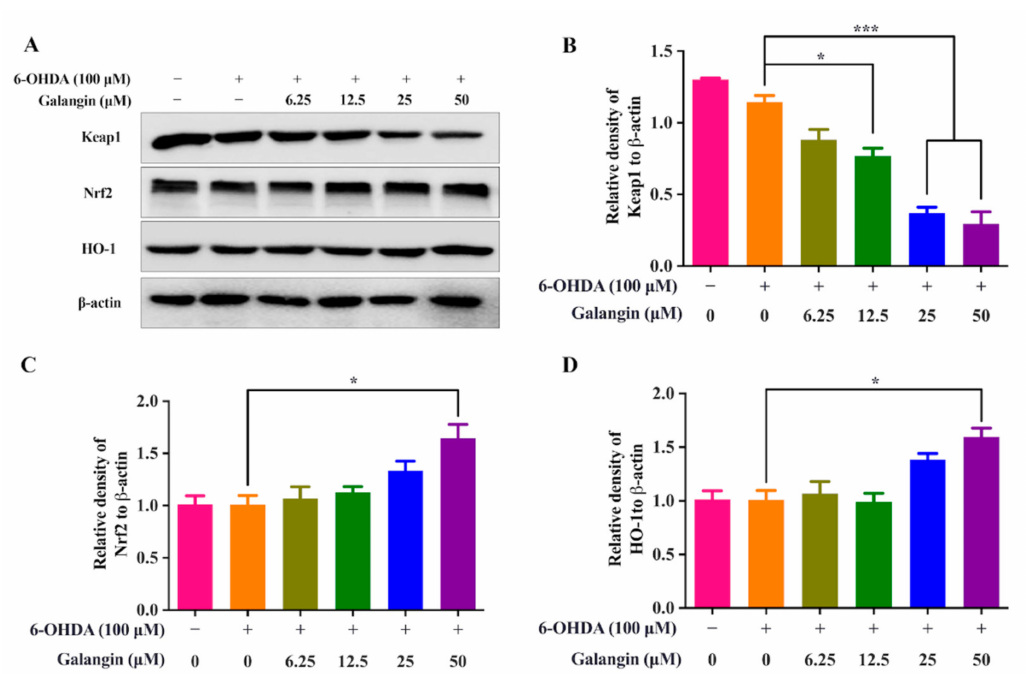
Figure 6. Galangin activates the Keap1/Nrf2/HO-1 signaling pathway. ( A ) HT22 cells were treated with galangin in the absence or presence of 6-OHDA at the indicated concentrations for 24 h. After treatment, cell lysates were collected and harvested for the protein detection of Keap1, Nrf2, HO-1, and β -actin by western blot. ( B ) The bar chart indicates the relative density of Keap1 to β -actin. ( C ) The bar chart indicates the relative density of Nrf2 to β -actin. ( D ) The bar chart indicates the relative density of HO-1 to β -actin. Bars, S.D., * p ≤ 0.05, *** p ≤ 0.001. The full-length Western blotting images are shown in Supplementary Figure